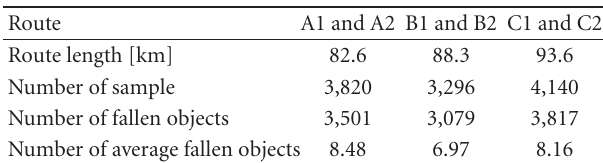
Table 1: Route data.